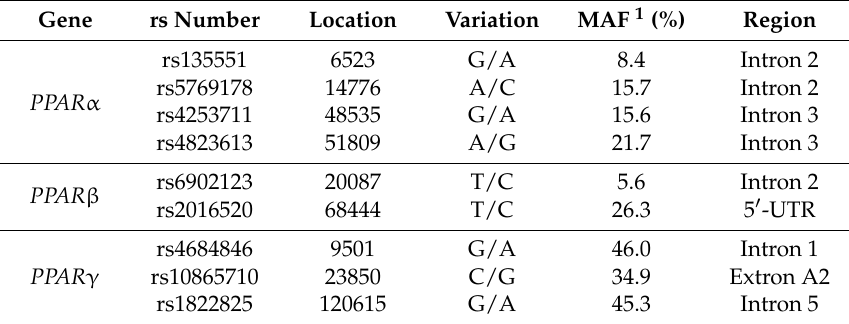
Table 1. SNPs identified within the PPAR family